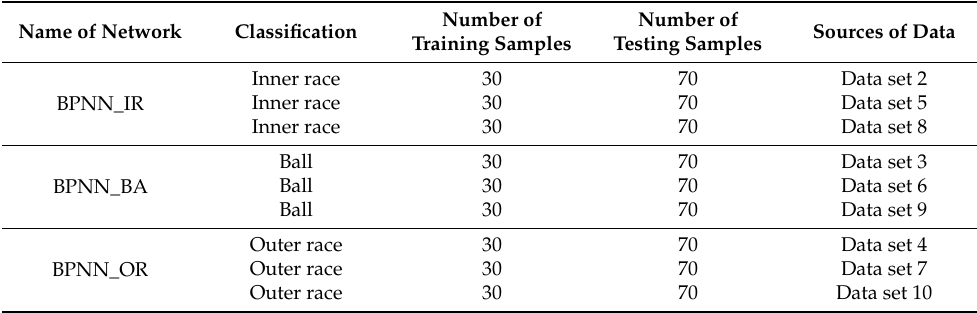
Table 4. Sample settings for the fault severity estimation